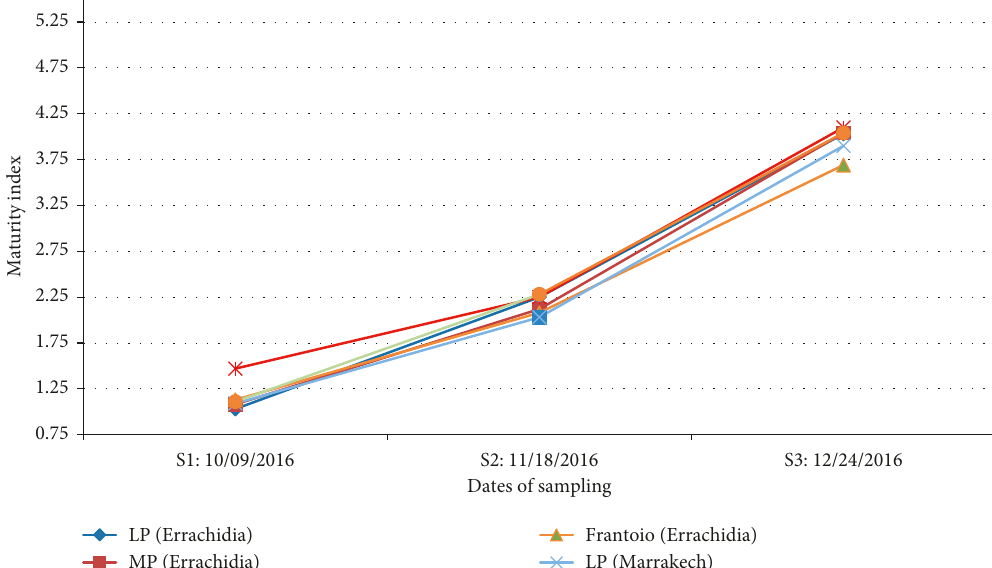
Figure 1: Olive maturity index evolution of the different cultivars grown in Marrakech and Errachidia regions during the 2016 season (LP: Languedoc Picholine; MP: Moroccan Picholine; Fr: Frantoio).